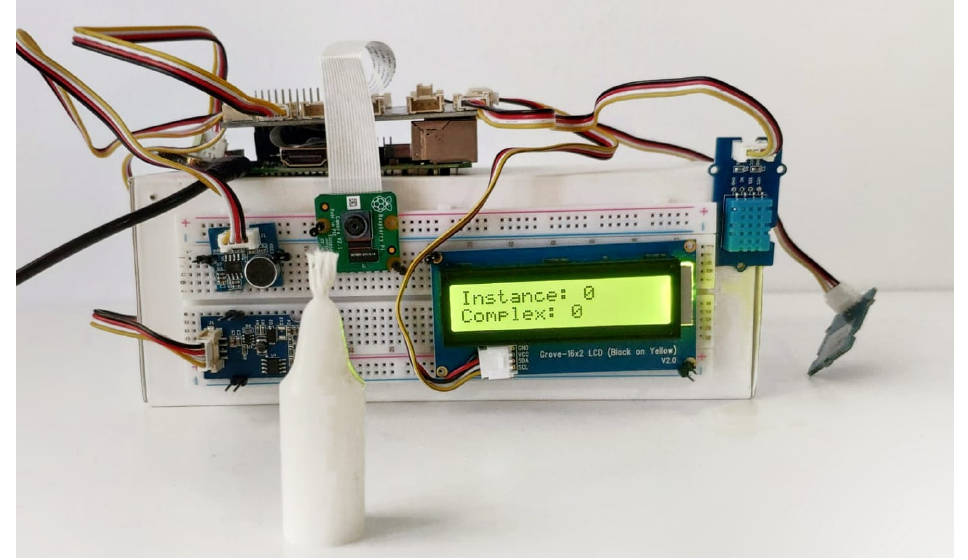
Figure 4. The experimental EDU when no event is being detected.